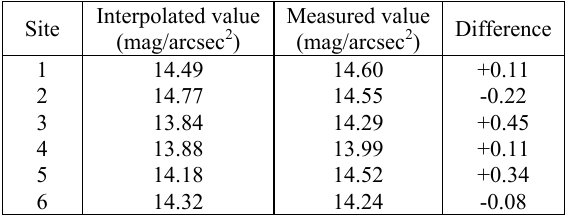
Table 2. Differences between the interpolated values and the measured values from the checking sites